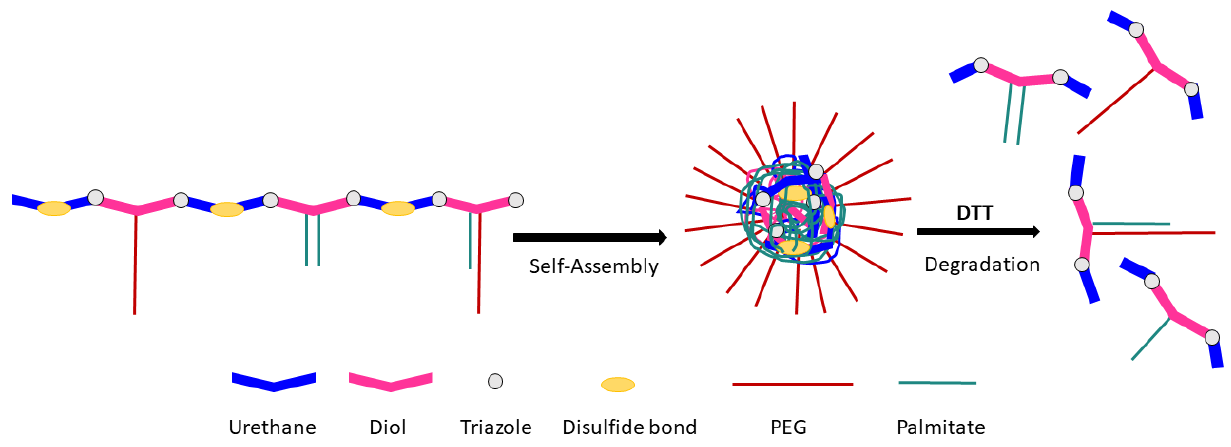
Figure 27. PEG-grafted PU amphiphilic polymers made by Zhang et al. [132]. The main chains are cleavable upon reduction.